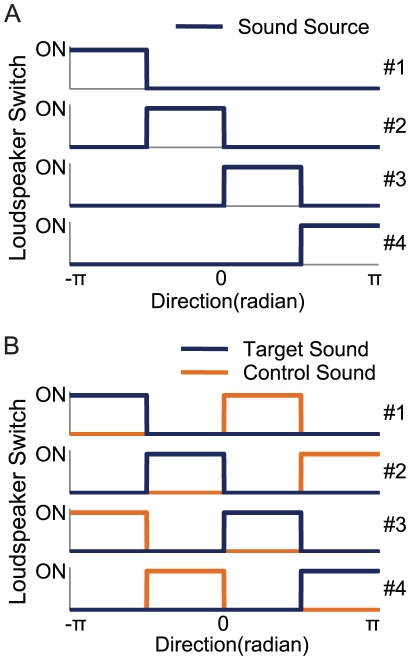
Control sequences between a honeybee's directions and the loudspeakers.The graphs demonstrate localization using either a single sound source (A) or two sound sources (B). The vertical axes show the state of each loudspeaker's switches (ON or OFF). The numbers on the right side of the graph indicate the loudspeaker number. The directions of each sound source were set negatively proportional to the voltage output of the torque meter attached to the honeybee's thorax. Whether a loudspeaker was turned on or off and which sound source it produced was decided by the directions of the sound source.